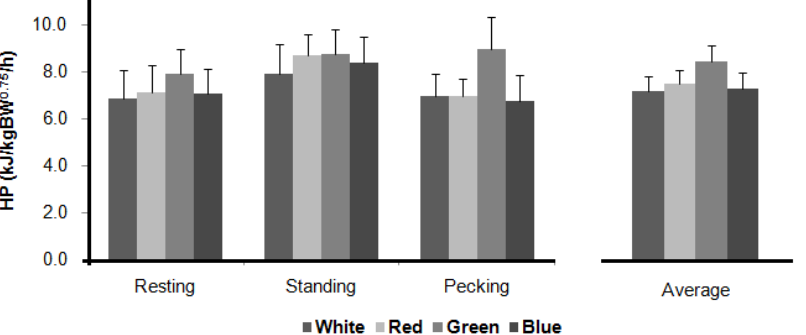
Figure 3. Energy expenditure of broiler chickens exposed to white, red, green or blue LED lights for 2 h. HP, heat production; BW, body weight; LED, light-emitting diode.